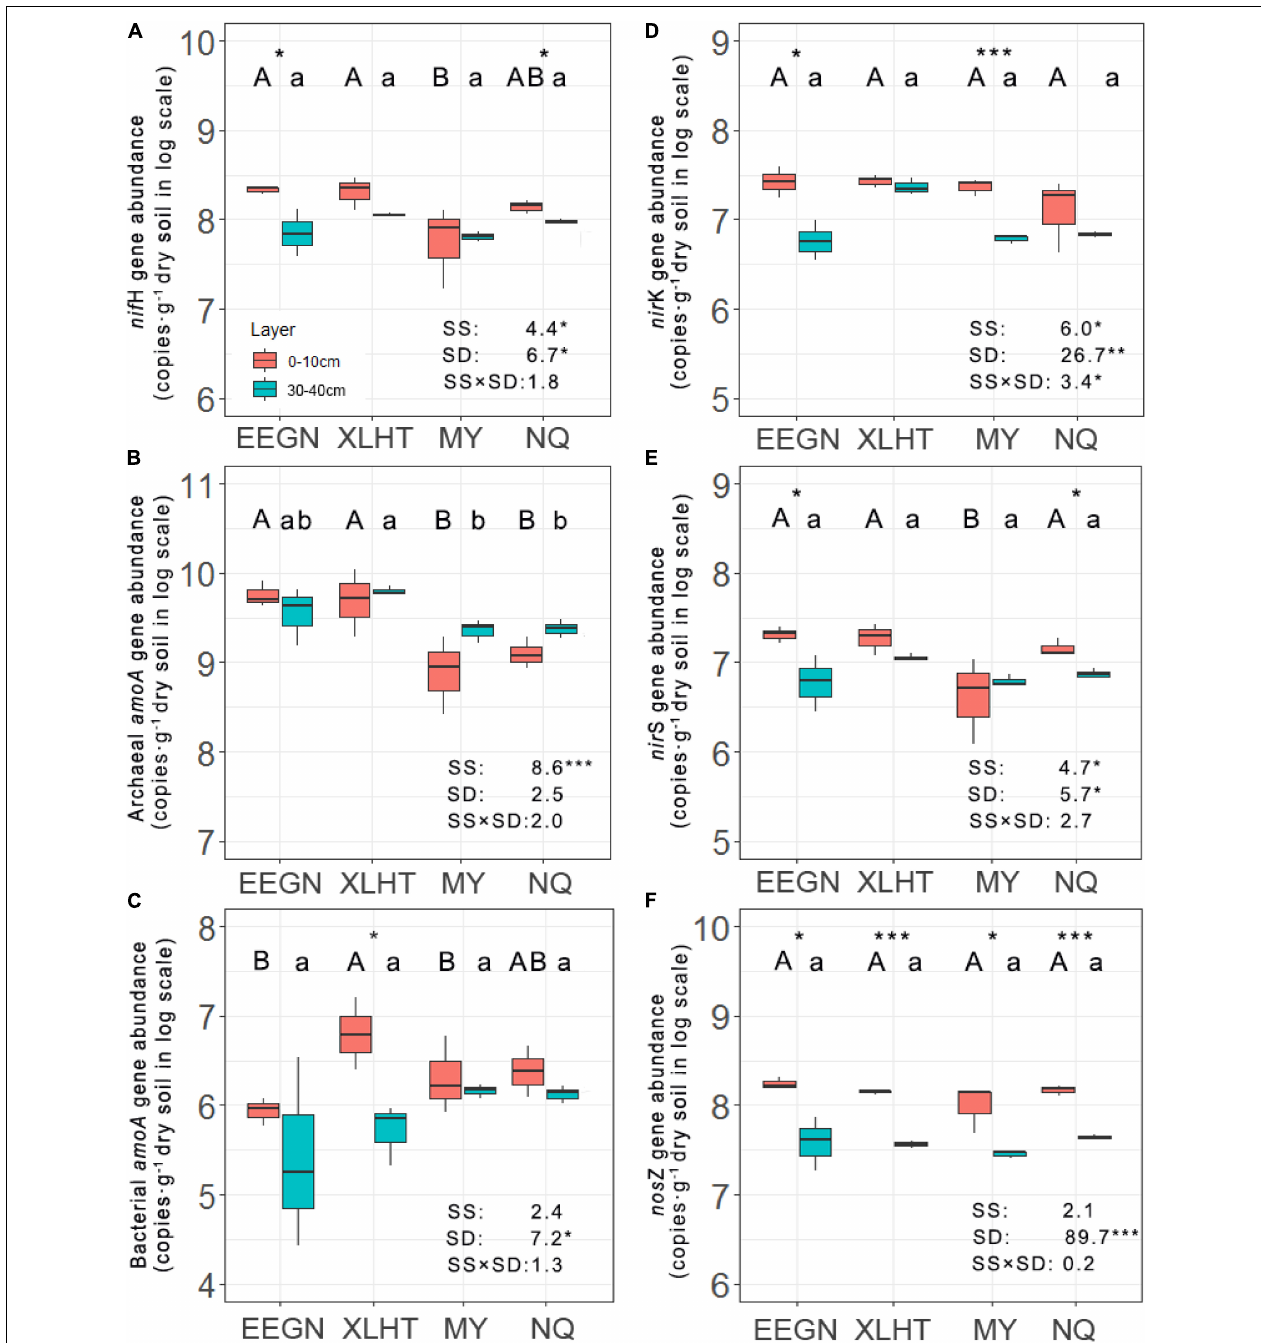
FIGURE 2 | Abundances of nifH (A) , archaeal amoA (B) , bacterial amoA (C) , nirK (D) , nirS (E) , and nosZ (F) genes at soil depths of 0–10 and 30–40 cm at four grassland sites. Different uppercase and lowercase letters above the boxes indicate significant differences at P < 0.05 between sites according to LSD post hoc test in the topsoil and subsoil, respectively. An asterisk above the boxes indicates a significantly different level at P < 0.05 according to the student t -test for a given site. An asterisk next to the number indicates a significantly different level at P < 0.05 according to multiple analyses of variance. SS, sampling site; SD, soil depth; SS × SD, sampling site × soil depth. * P < 0.05; ** P < 0.01; *** P < 0.001. The site abbreviations are defined in Table 1 .